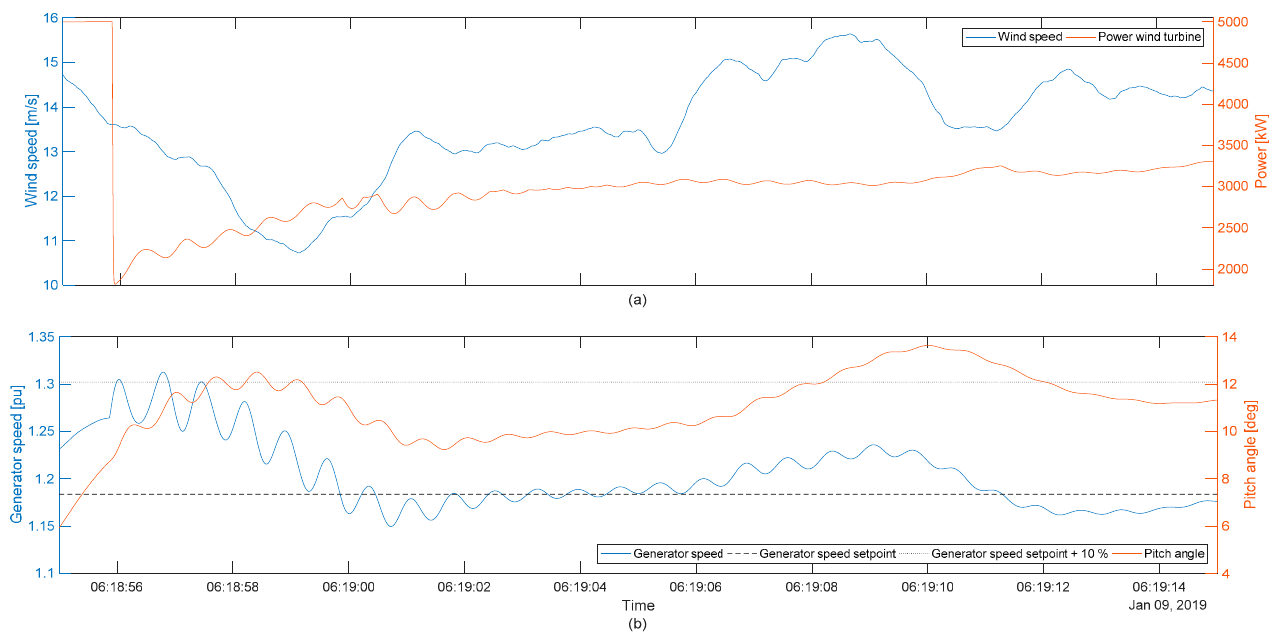
Figure 9. Results of scenario I for the 1st simulated WT: ( a ) Wind speed at hub height and electrical power of the WT; ( b ) generator speed, speed setpoint, overspeed threshold and pitch angle.